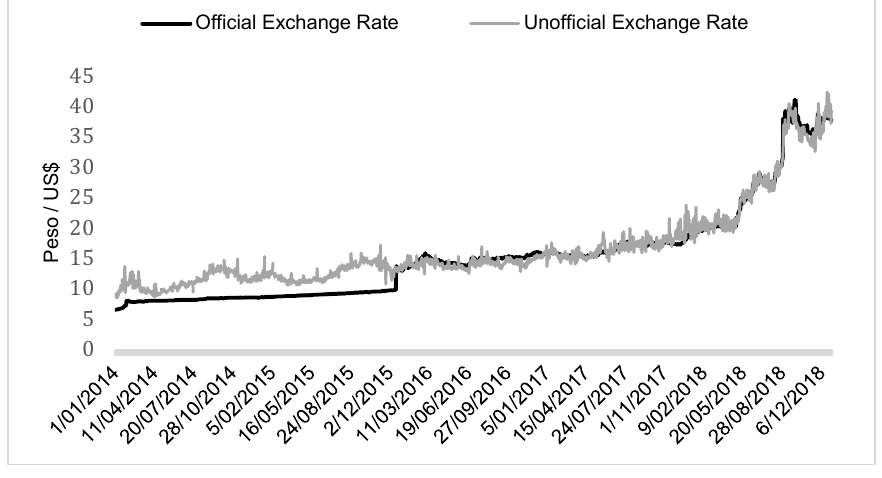
Fig. 1. Argentinian official and unofficial exchange rates from 2014 to 2018 .